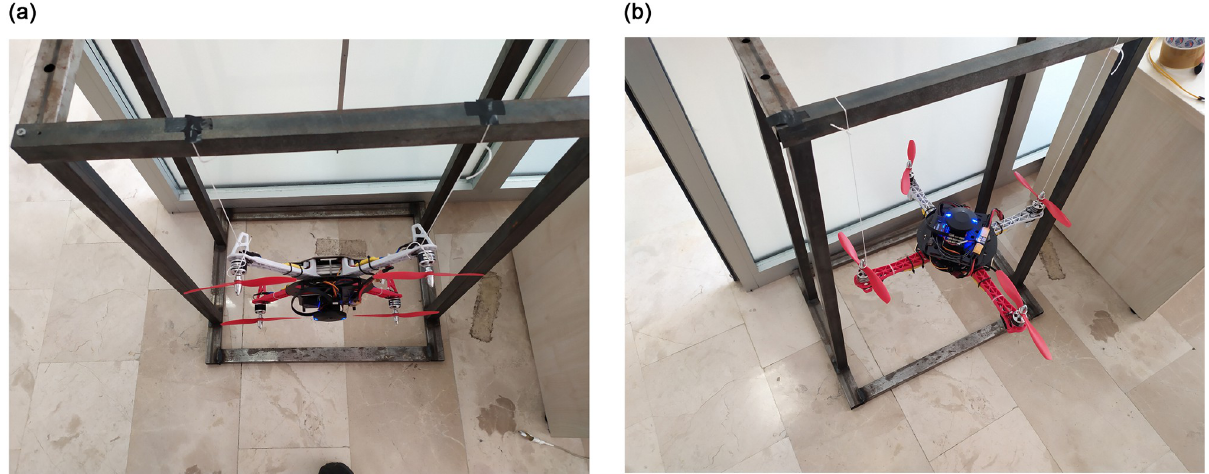
Fig 11. Experimental setup to perform the Bifilar pendulum experiment. (a) Roll test configuration. (b) Yaw test